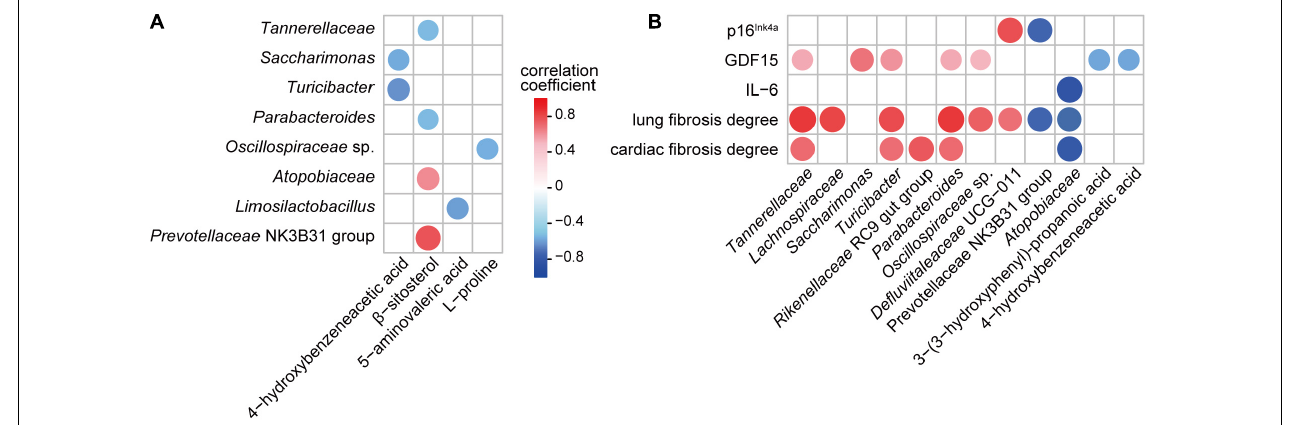
FIGURE 6 | Associations among gut bacteria, metabolites, and aging-related indicators influenced by parishin ( P < 0.05). (A) Correlation of parishin-influenced gut microbes with gut metabolites. (B) Correlation of parishin-influenced microbes and metabolites with serum biomarkers and cardiopulmonary fibrosis